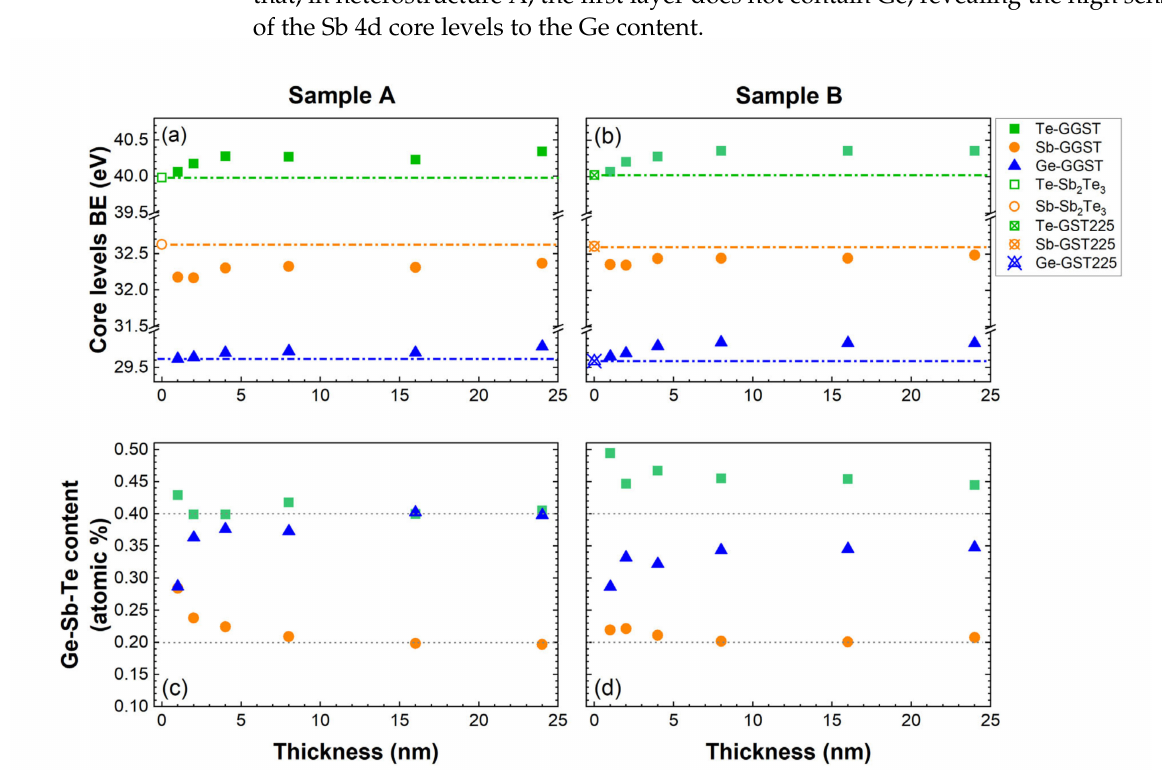
Figure 3. Core level BEs of the Sb 2 Te 3 Te 4d and Sb 4d (open green square and orange circle, respectively), GST225 Te 4d, Sb 4d, Ge 3d (open crossed green square, orange circle, and blue triangle, respectively), and GGST Te 4d, Sb 4d, Ge 3d (green squares, orange circles, and blue triangles, respectively) for sample A ( a ) and sample B ( b ) as a function of the GGST layer thickness as estimated by fit deconvolution of the XPS spectra of Figure 1. The evolution of the composition of the GGST layer is shown for sample A ( c ) and sample B ( d